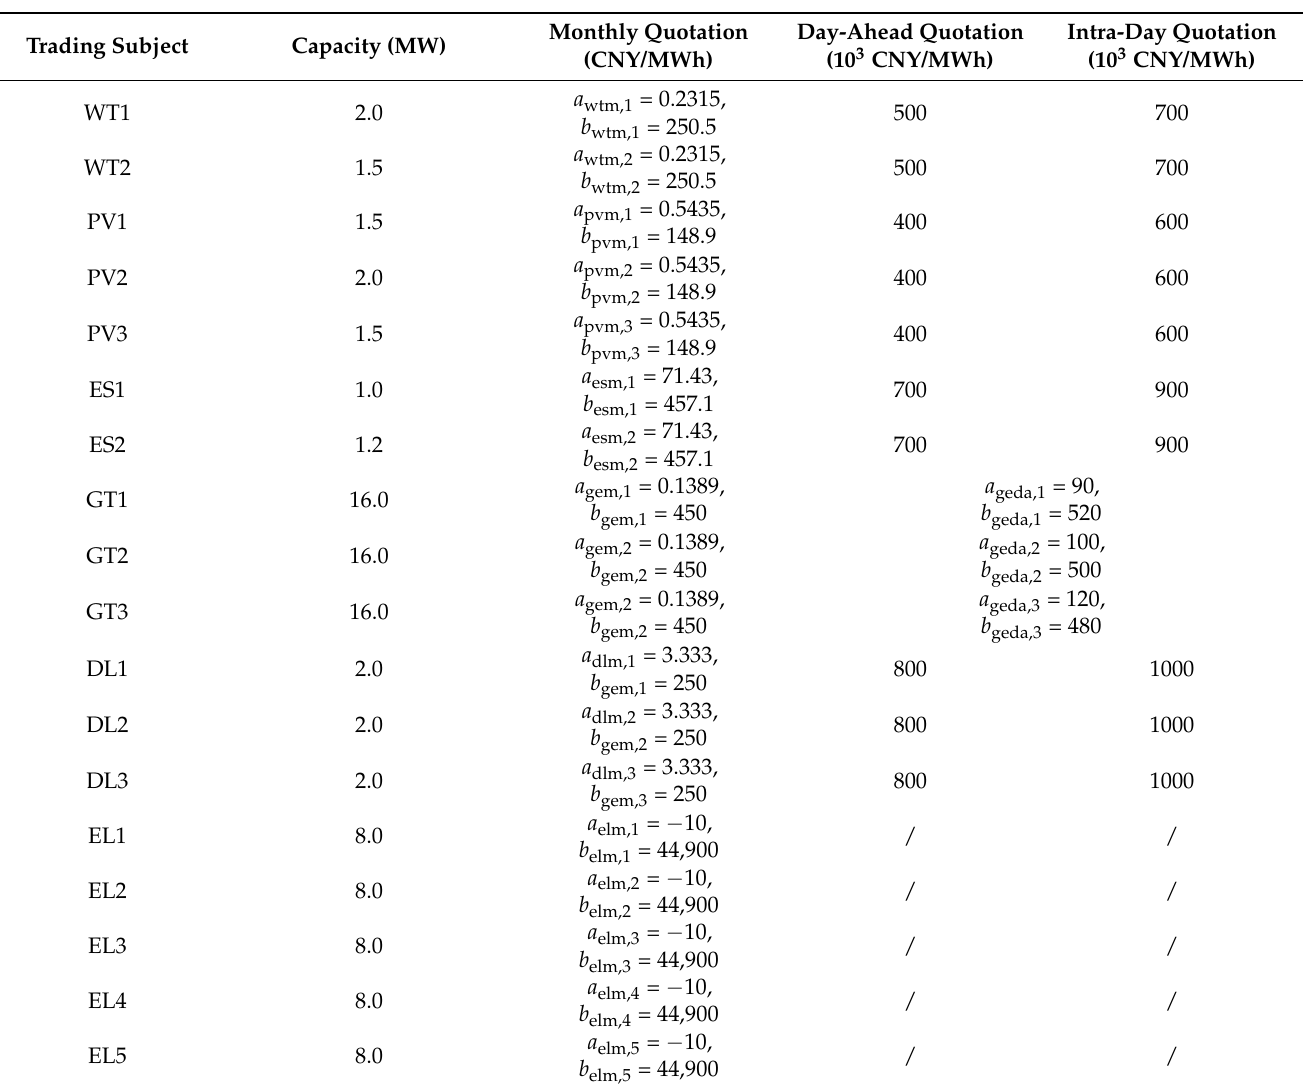
Table 1. Basic data of the calculation